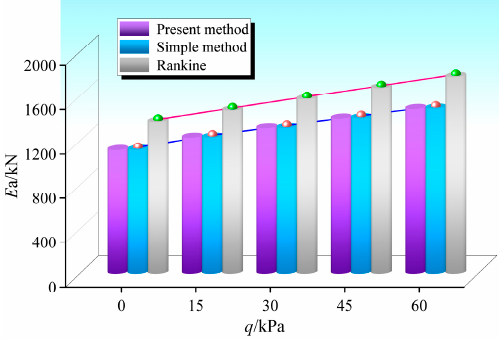
Figure 22. The influence of the ground overload.